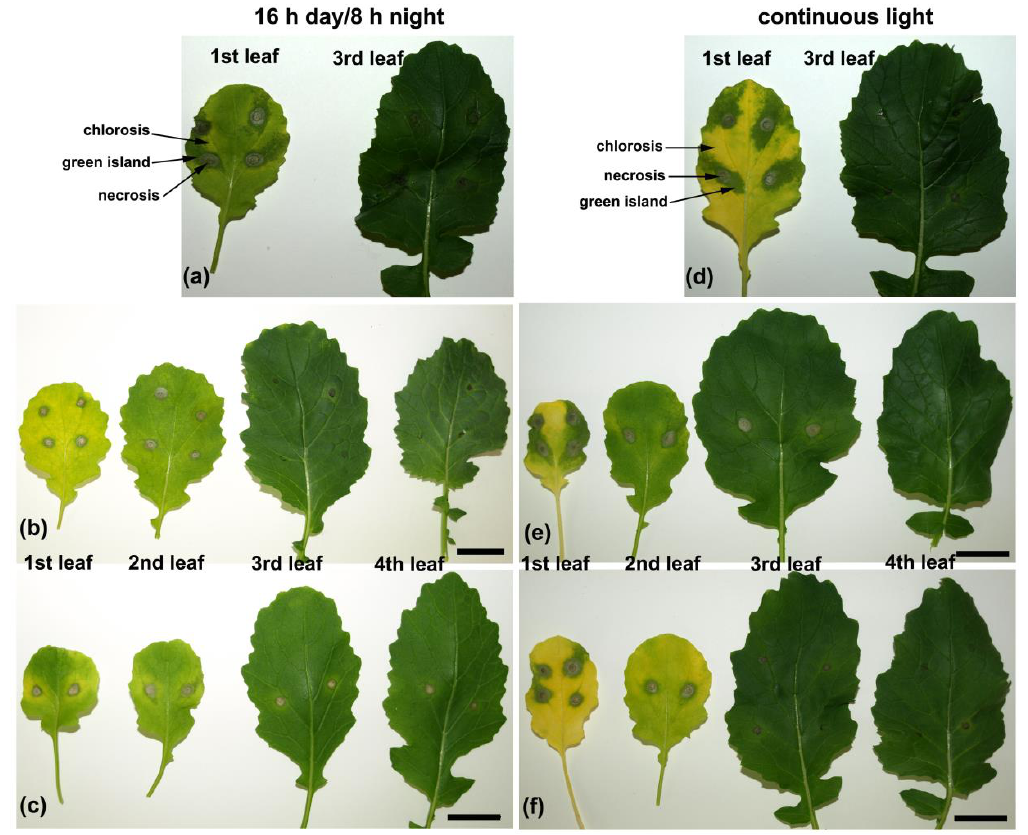
Figure 6. ‘Green island’ phenotypes on B. juncea leaves infected with A. brassicicola at 48 hpi. Plants were grown under a 16 h day/8 h night photoperiod ( a – c ) and continuous light ( d – f ) for 35 days. Four fully developed leaves were infected. The 1st leaf is the oldest. The experiment was independently repeated twice. Scale bars = 20 mm.